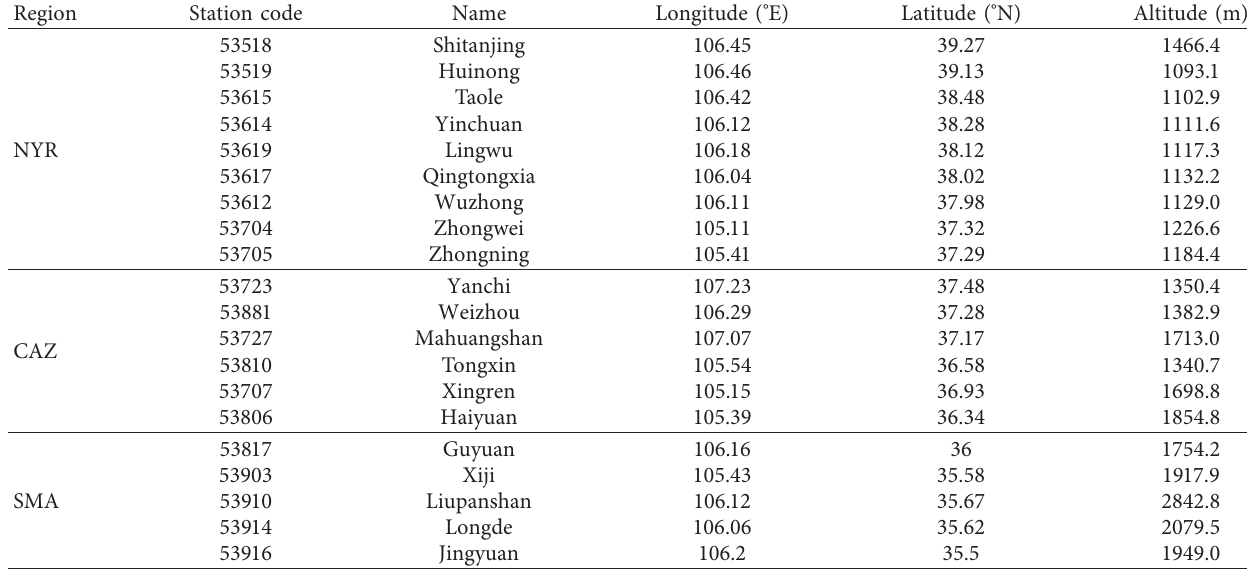
Table 1: Basic information for the national climate stations used in the study area. Region Station